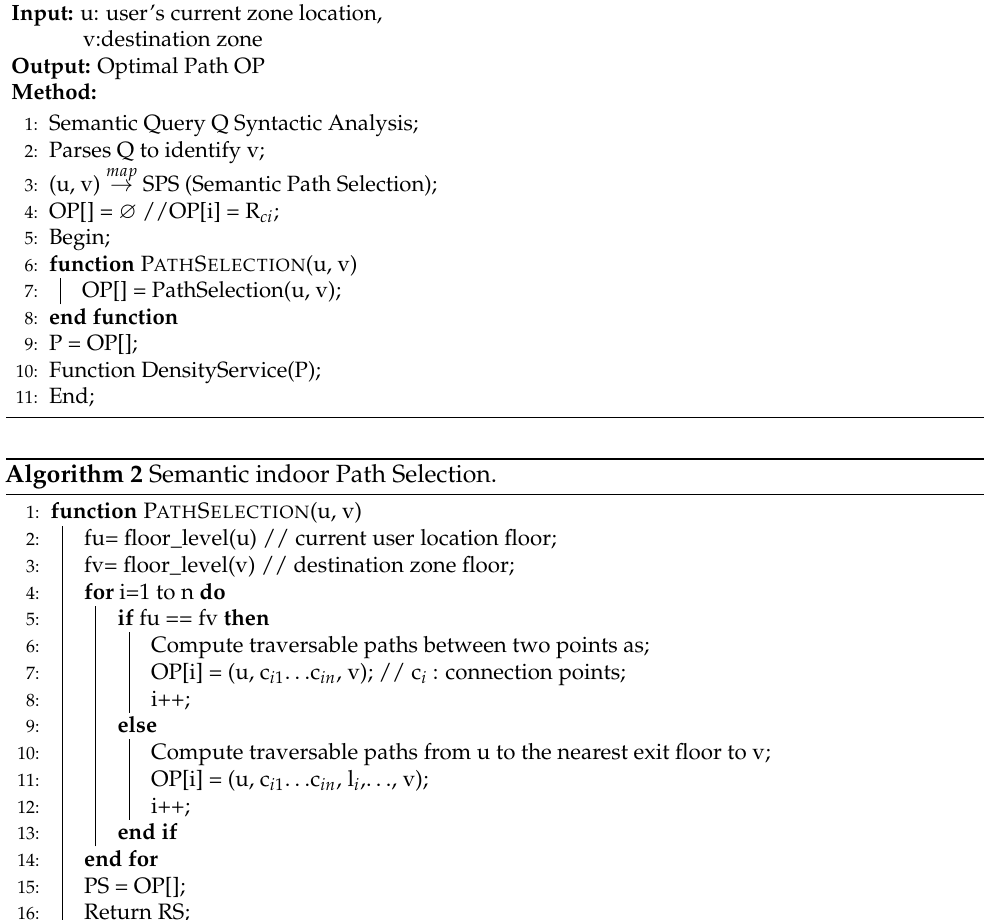
Algorithm 1 Semantic indoor navigation pseudocode.